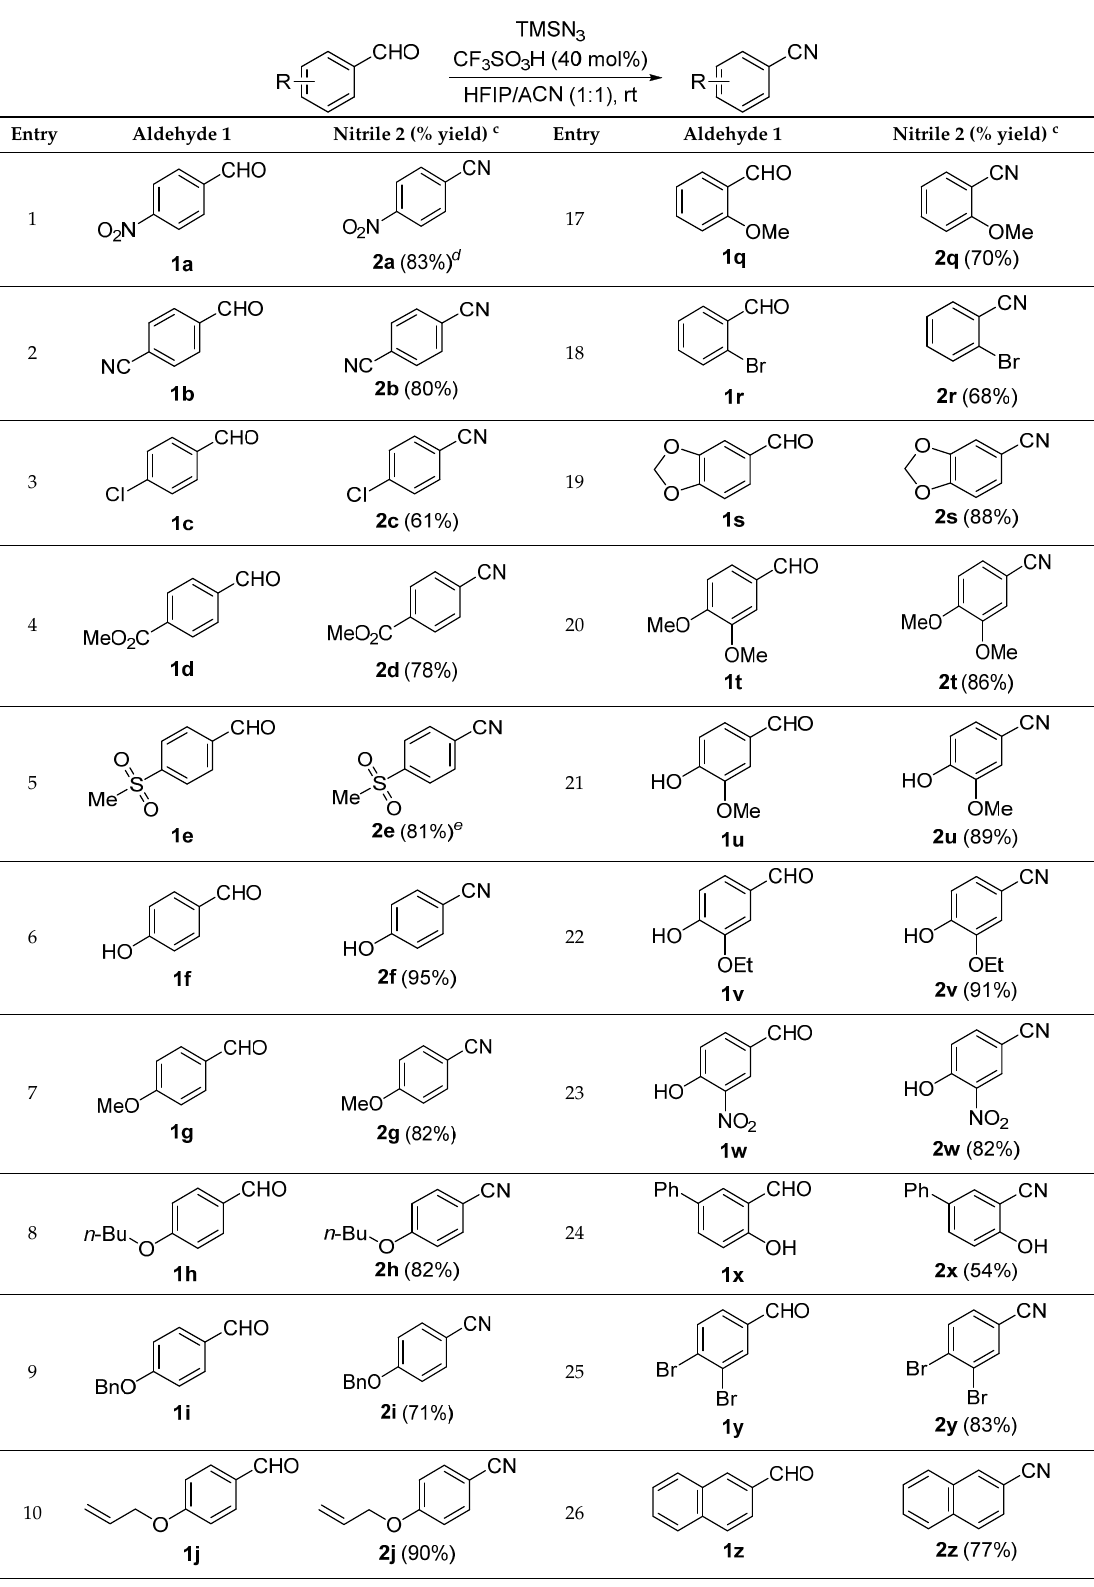
Table 2. Scope of Aromatic Aldehydes a,b .